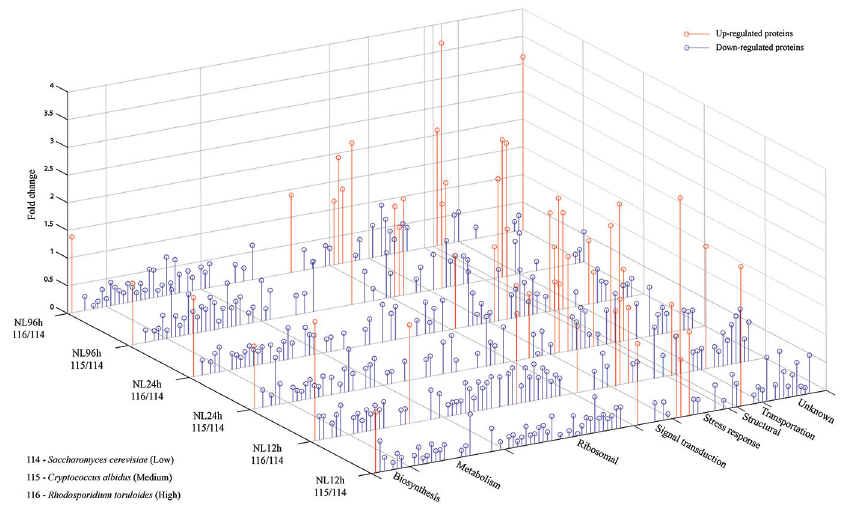
Figure 6. Fold change of proteins of different functional distribution at 12h, 24h and 96h. ‘NL’ represented nitrogen limited medium; red circles represented fold change of up-regulated proteins; and blue circles represented fold change of down-regulated proteins.